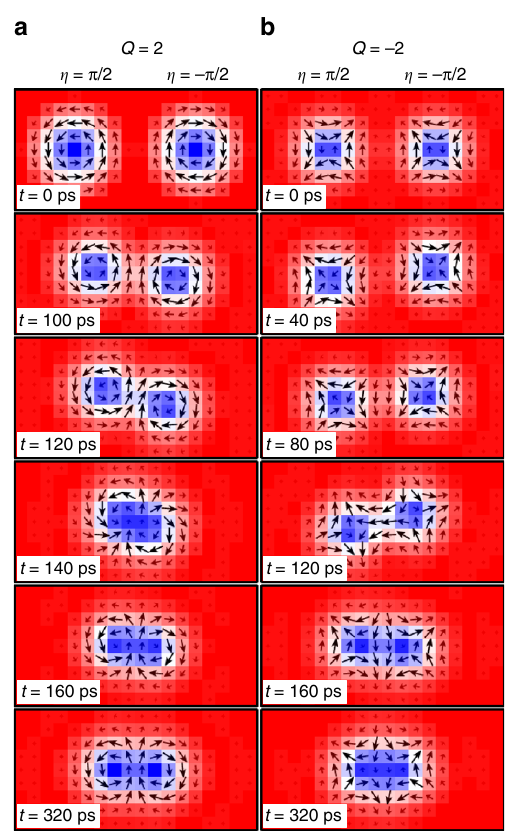
Fig. 8 Spontaneous formations of a bi-skyrmion and a bi-antiskyrmion. a Spontaneous formation of a bi-skyrmion by merging two skyrmions with different η . b Spontaneous formation of a bi-antiskyrmion by merging two antiskyrmions with different η . The model is a square element (18 × 9 spins) with the OBC. The parameters are J 2 = − 0.8, J 3 = − 1.2, K = 0.1, H z = 0.1, and α =